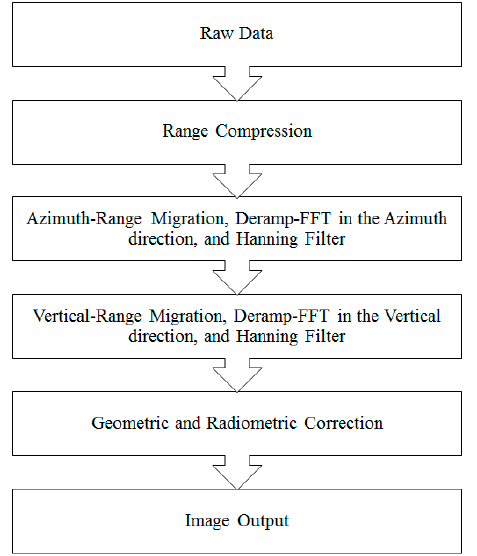
Figure 2. Flow chart of GB-TomoSAR focusing algorithm.